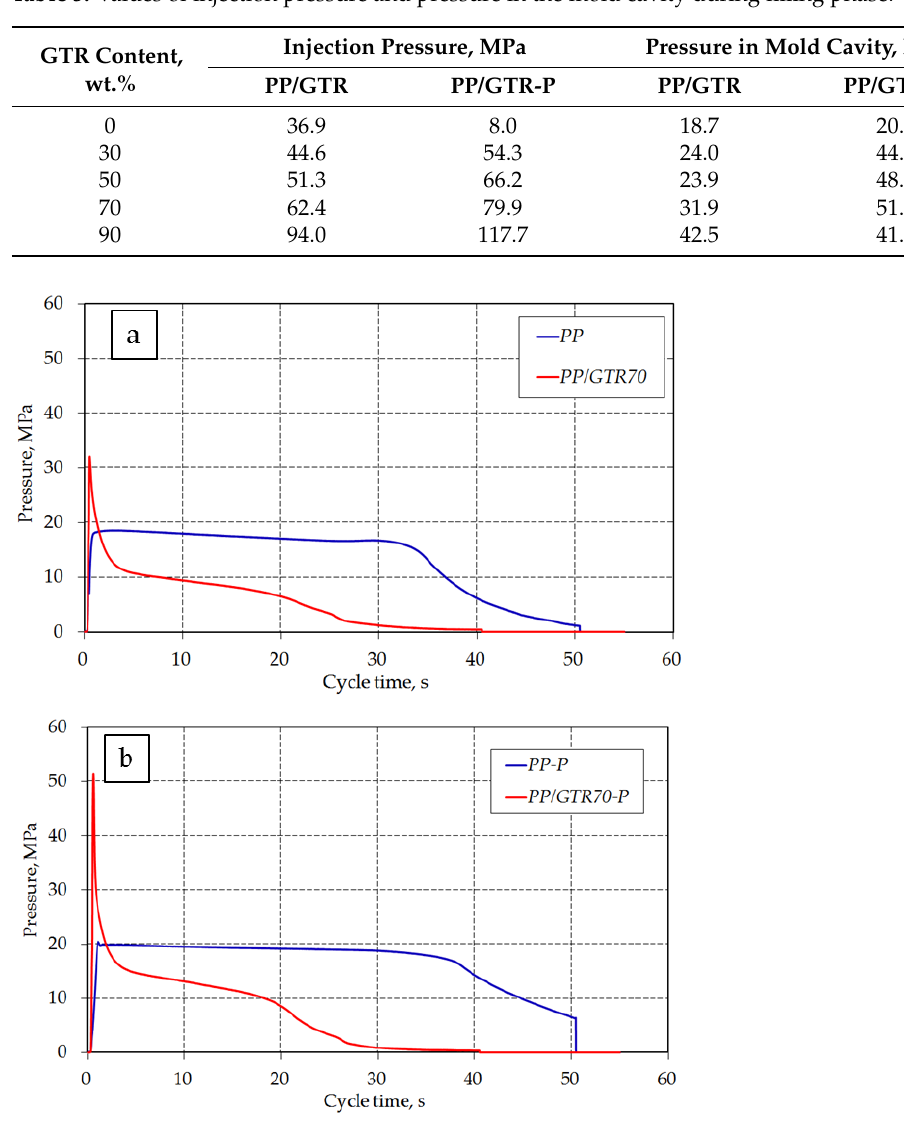
Table 3. Values of injection pressure and pressure in the mold cavity during filling phase.